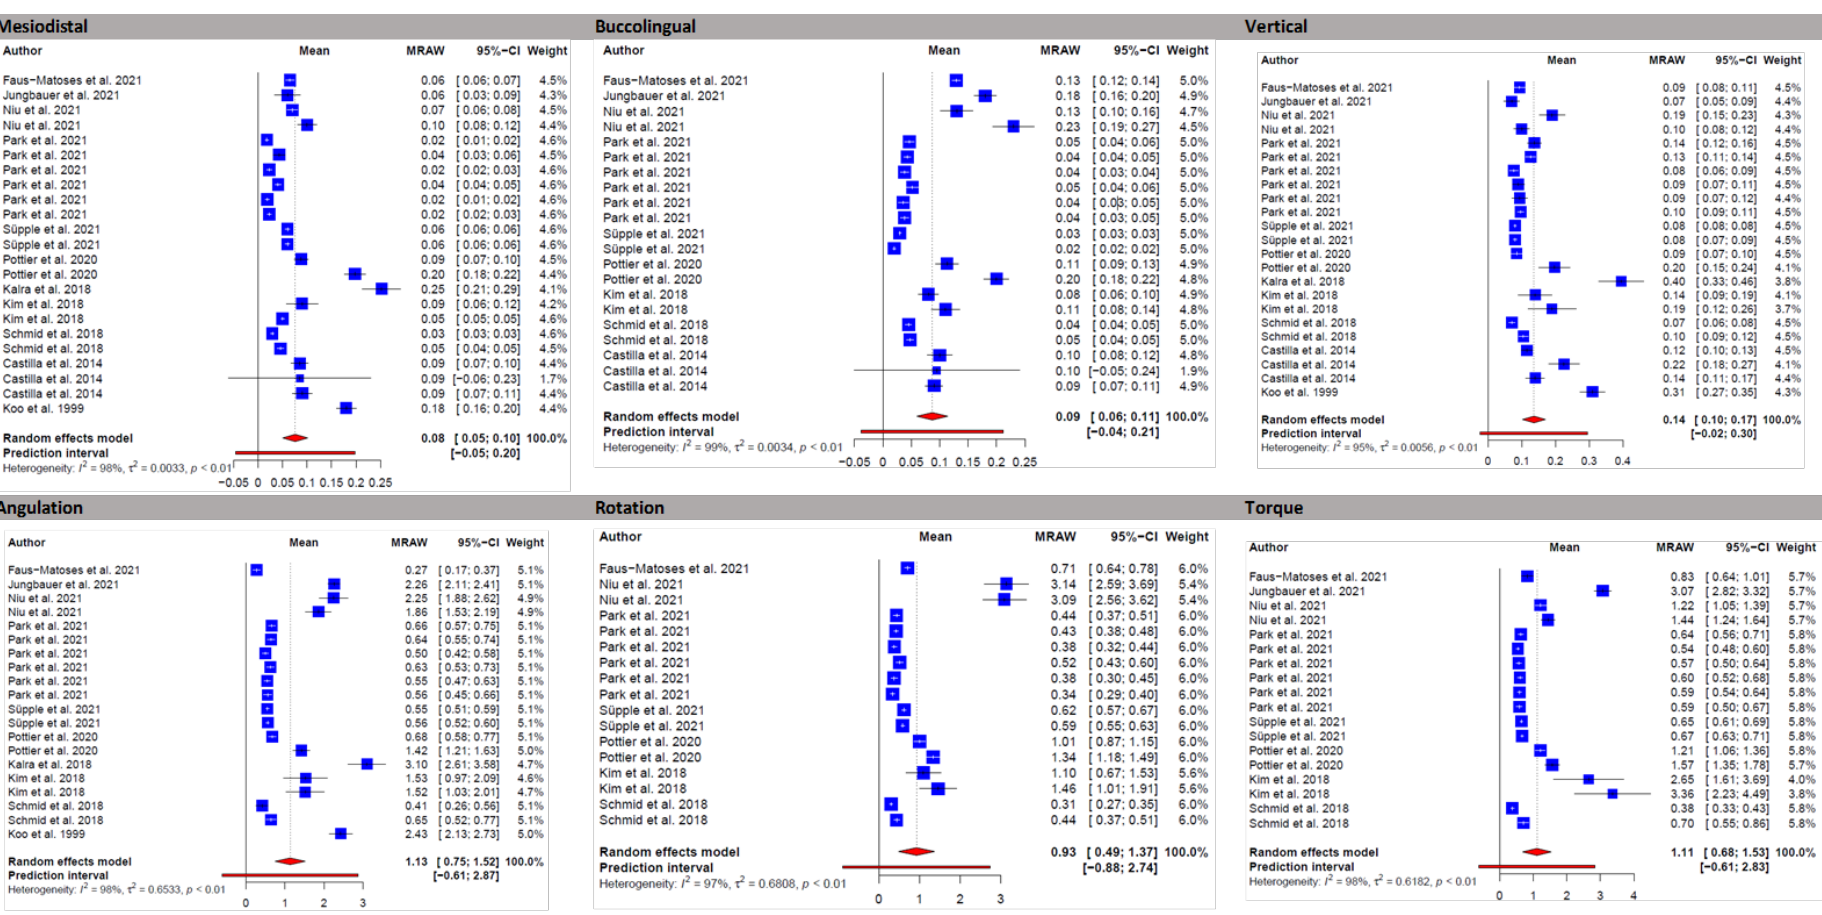
Figure 3. Forest plots showing overall linear and angular mean bracket transfer errors (MTE) [10,18,27,28,32,43 – 46,49 – 51].